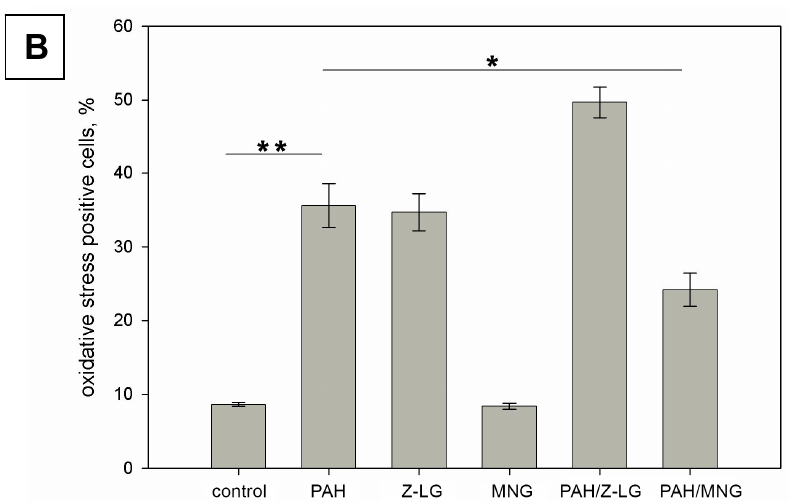
Figure 2. The effects of polycyclic aromatic hydrocarbons (PAH) extract (containing 2 nM of benzo(a)pyrene (BaP)), Z-ligustillide (Z-LG, 0.5 µ g/mL), mangiferin (MNG, 0.5 µ g/mL) or combination thereof on the levels of oxidative stress in BEAS-2B cells. ( A ) PAH-induced oxidative stress in BEA-2B cells was assessed by means CellROX ® Green Reagent. Green areas represent cells with ongoing oxidative stress. Magnification 20X. ( B ) Oxidative stress undergoing cell were identified using Muse ® Oxidative Stress Kit and Muse ® cytometer. Data are presented as mean ± SD from 3 independent experiments. Significance is indicated as follows: * for p < 0.05, ** for p < 0.01.